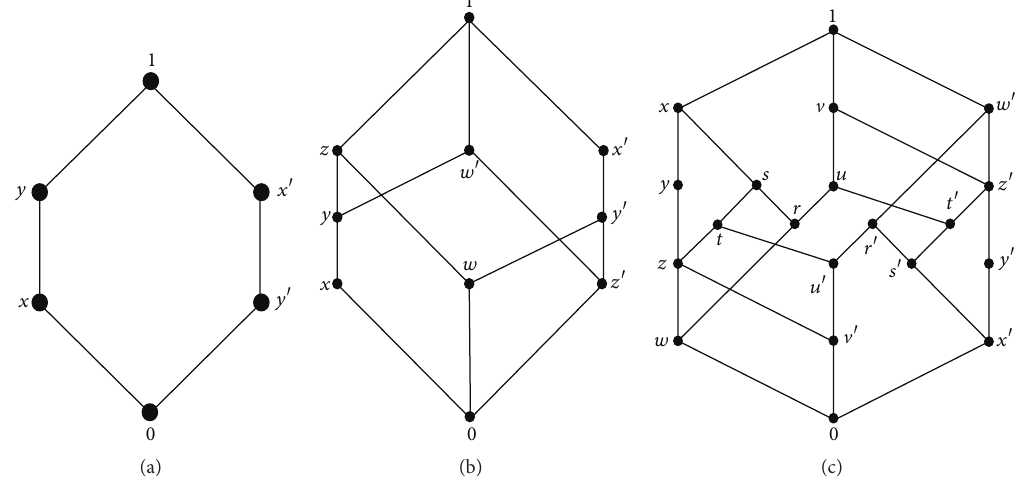
Figure 1: (a) O6; (b) O7 (Beran, Figure 7b [31]); (c) O8 (Rose–Wilkinson-1